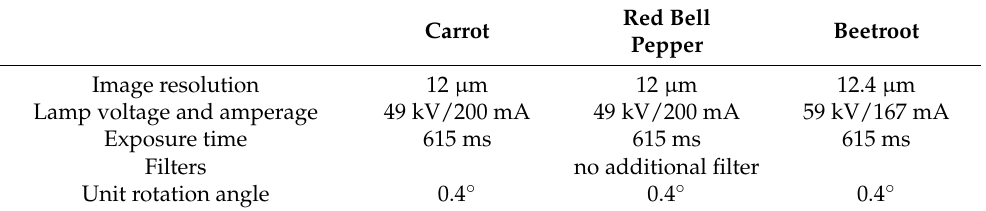
Table 1. Specimen registration parameters, 1172 SkyScan Bruker ® X-ray microtomograph. Red Bell Beetroot Carrot Pepper Image resolution 12 µ m 12 µ m 12.4 µ m Lamp voltage and amperage 49 kV/200 mA 49 kV/200 mA 59 kV/167 mA Exposure time 615 ms 615 ms 615 ms Filters no additional